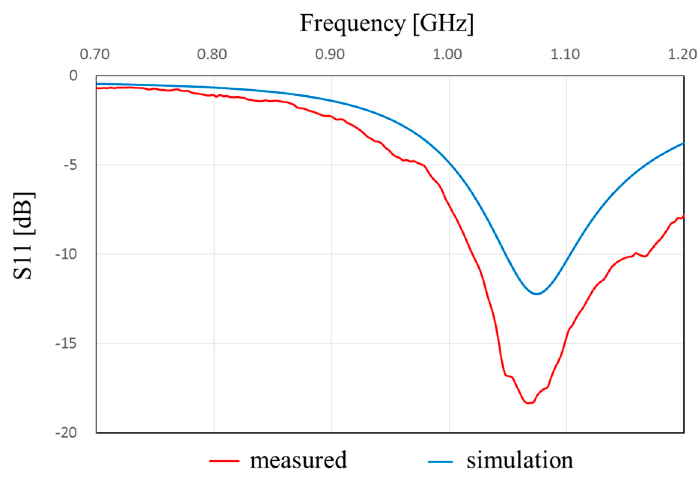
Figure 13. Frequency characteristics of S 11 .of the proposed antenna in Case A.